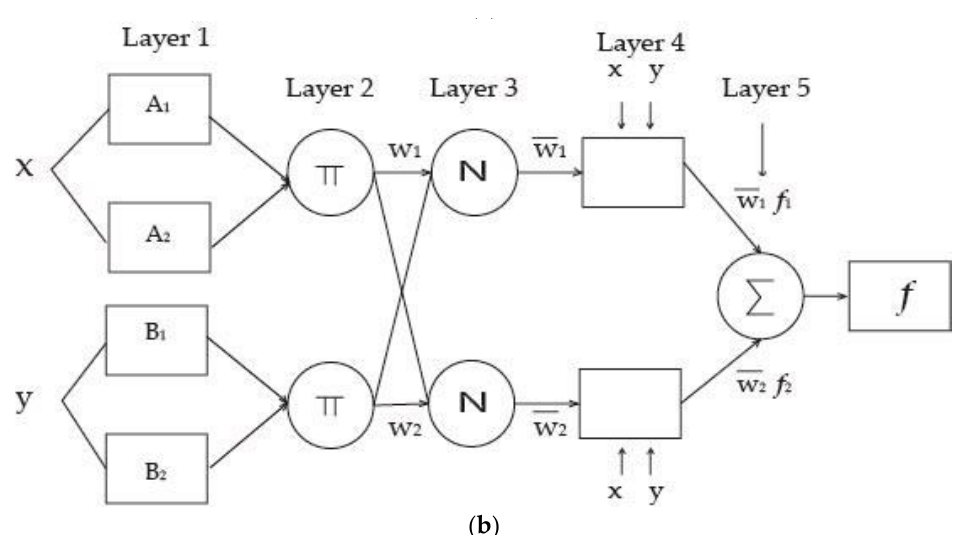
Figure 4. The architecture of an ANFIS model. ( a ) interpretation of the inputs in the membership functions; ( b ) graphical representation of an ANFIS system.